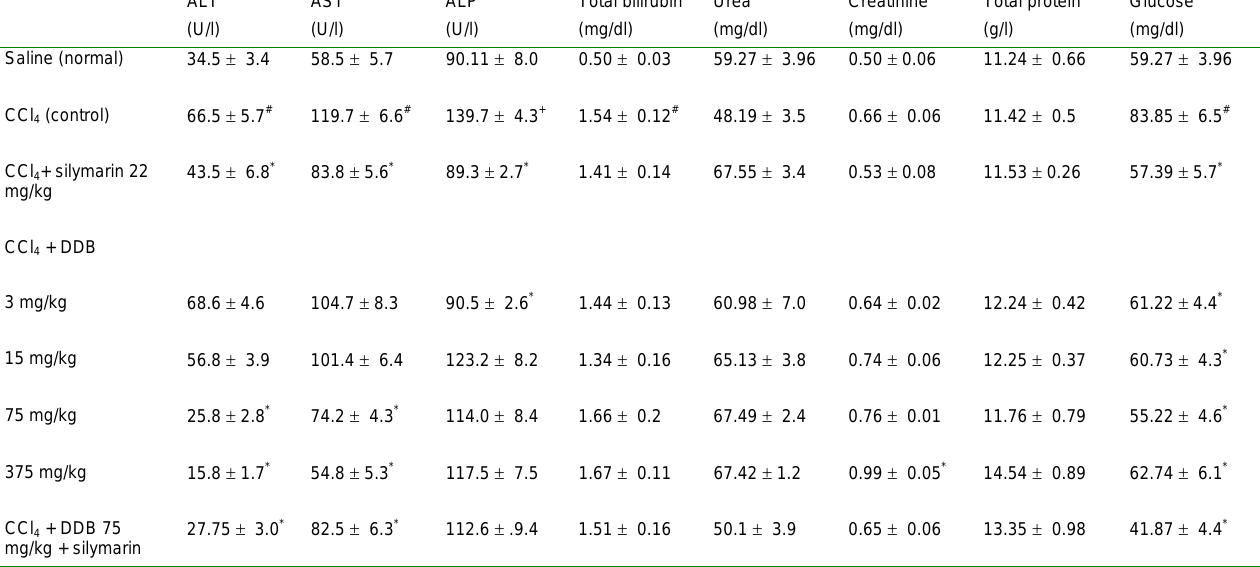
Serum bilirubin, urea, creatinine, proteins, glucose and enzyme activities of alanine aminotransferase (ALT), aspartate aminotransferase (AST) and alkaline phosphatase (ALP) in CCl -treated rats treated with biphenyldimethyl-dicarboxylate (DDB) and/or 4